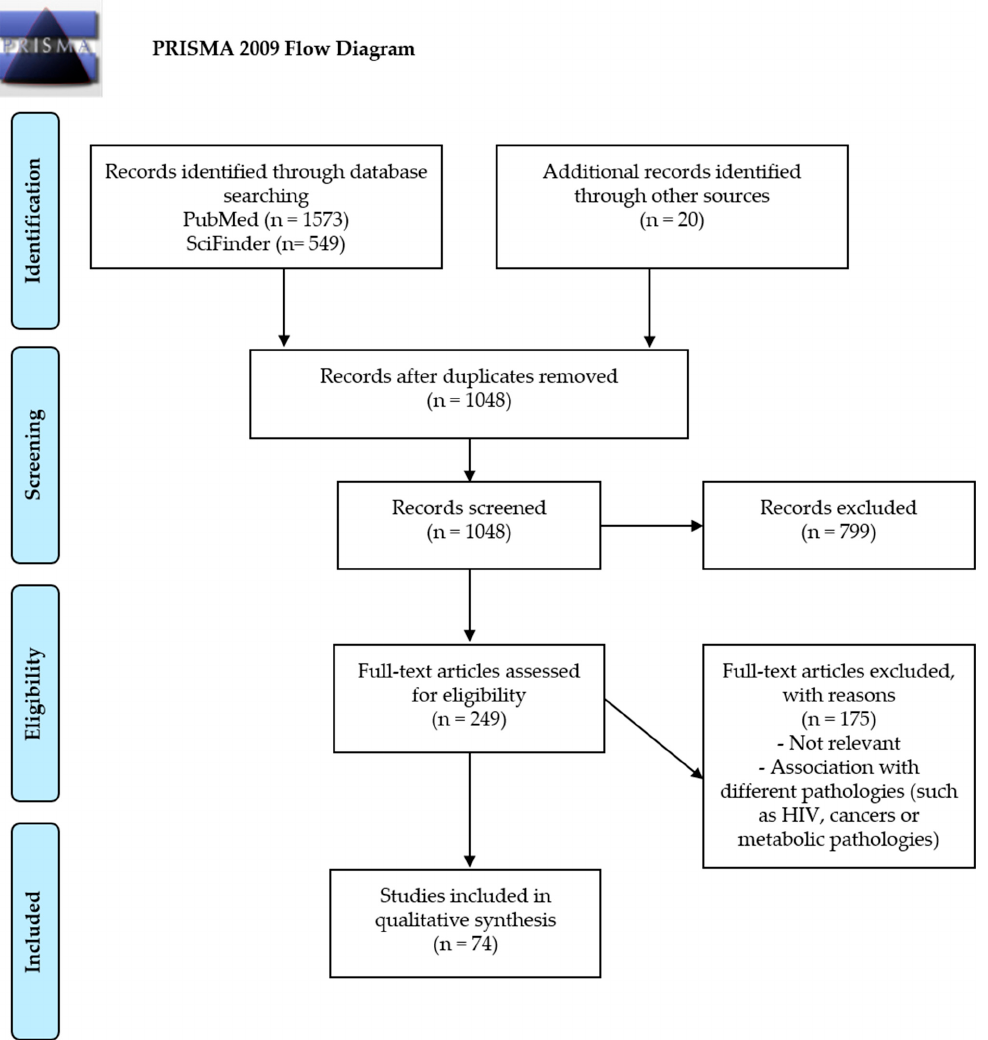
Figure 1. PRISMA (preferred reporting items for systematic reviews and meta–analyses) 2009 flow diagram from Moher, D. et al . [11].